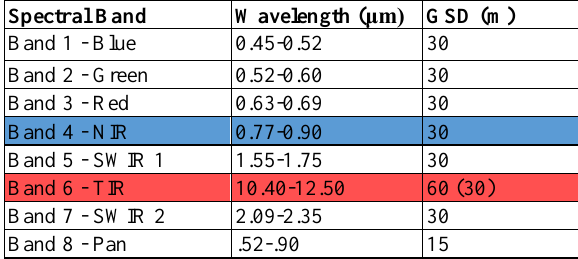
Table 5. Landsat 7 ETM+ spectral band characteristics (USGS,